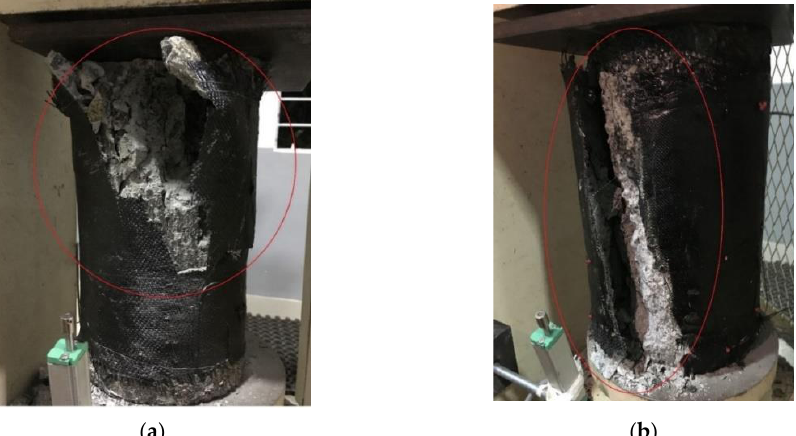
Figure 9. Failure pattern of confined HSBFRP specimen exposed to elevated temperature: ( a ) C- E0C2S2B400; and ( b ) C-E1C2S2B400.